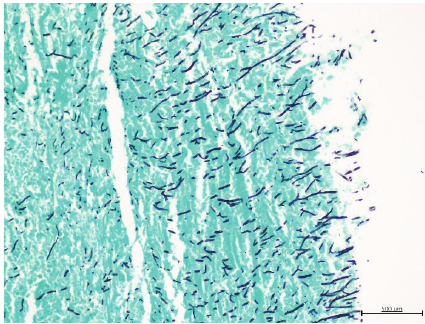
Figure 3: Grocott-Methenamine-Silver stain of biopsy of tracheal lesion showing acute angle hyphae with underlying necrosis ( ×